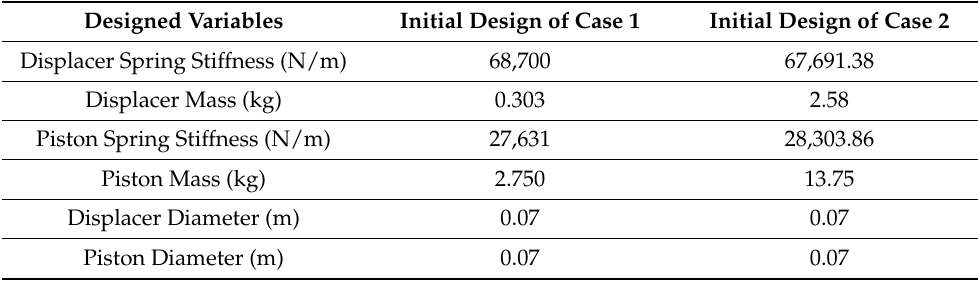
Table 1. Initial designs of Cases 1 and